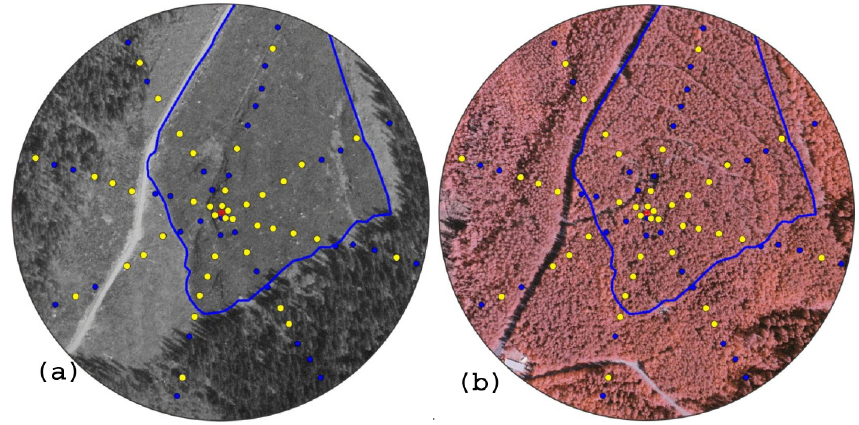
Fig. 2. Aerial photographs of the sample area. Sampling grid is marked with blue (no sample) and yellow (sampled) circles. (a) SMEAR II stand (marked with blue line) and neighbouring stands in 1962; (b) Same stands in 1997. Red dot=mast; diameter of circle